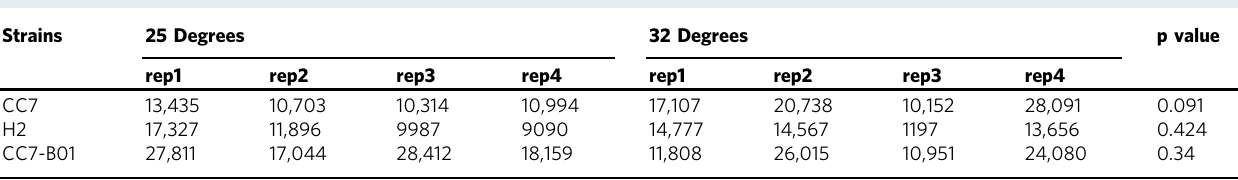
Table 1 Normalized symbiont density ( n = 4 per strain-temperature combination).